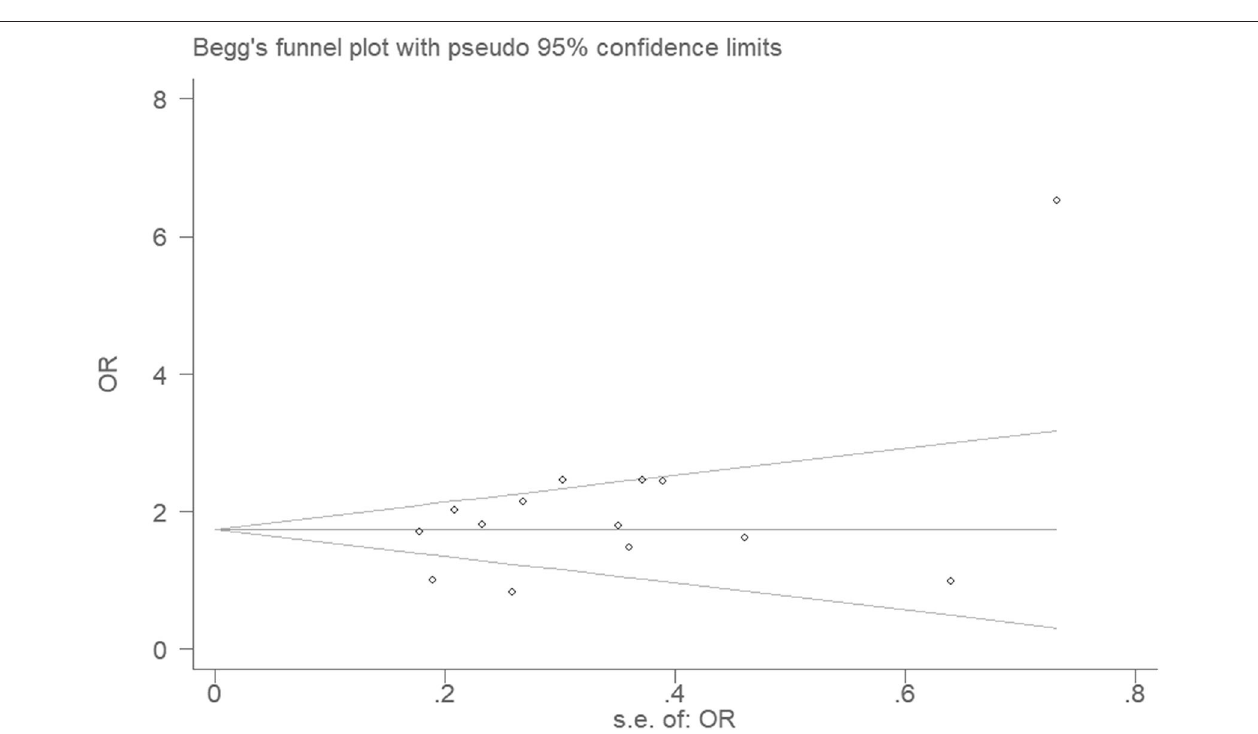
FIGURE 6 | Begg’s funnel plot for studies of the association of CAD and PCSK9 gene E670G polymorphism under an allelic genetic model (distribution of G allele frequency of PCSK9 gene E670G polymorphism). The horizontal and vertical axis correspond to the OR and confidence limits. OR, odds ratio; SE, standard error.